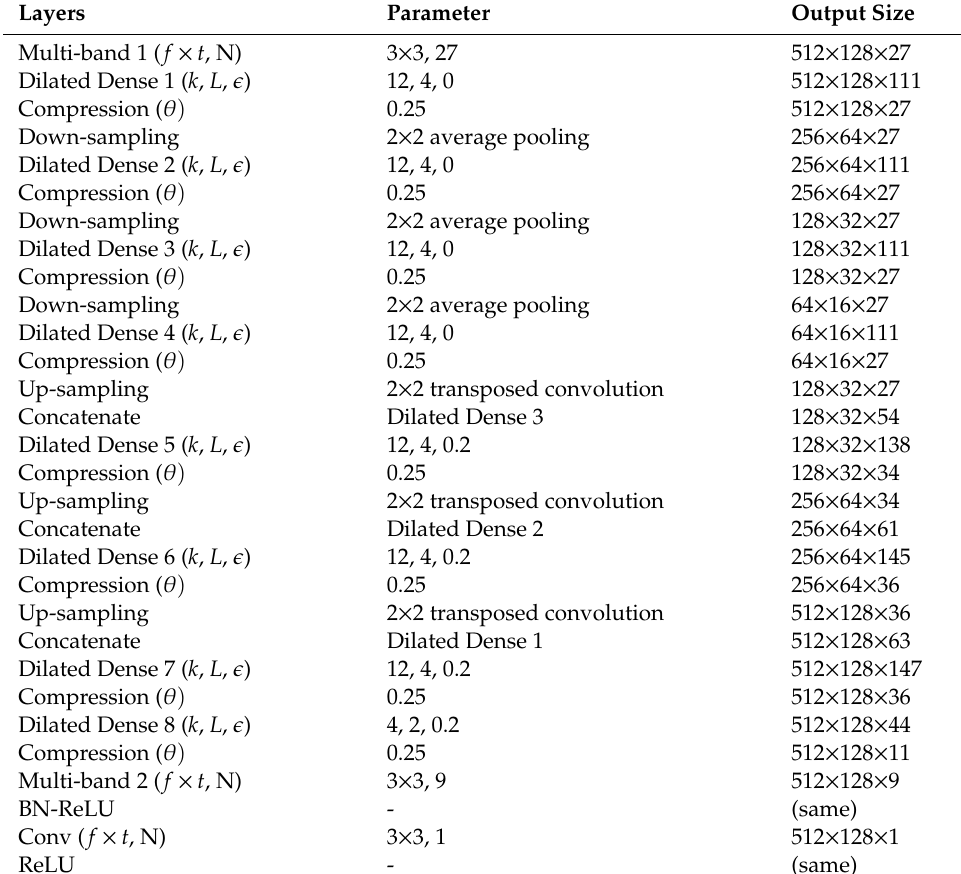
Table A1. Details of the proposed